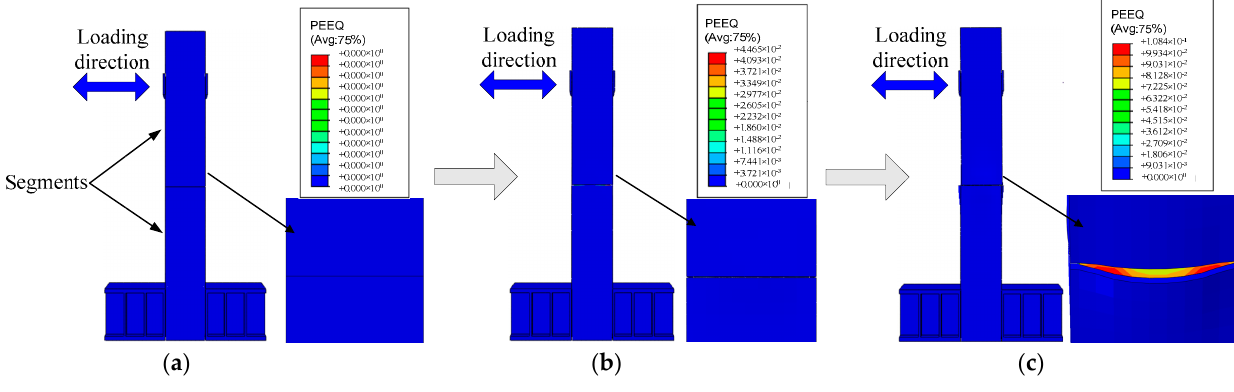
Figure 13. Deformation of specimen R2 during loading; ( a ) Prophase; ( b ) Metaphase; ( c ) δ = 4%.